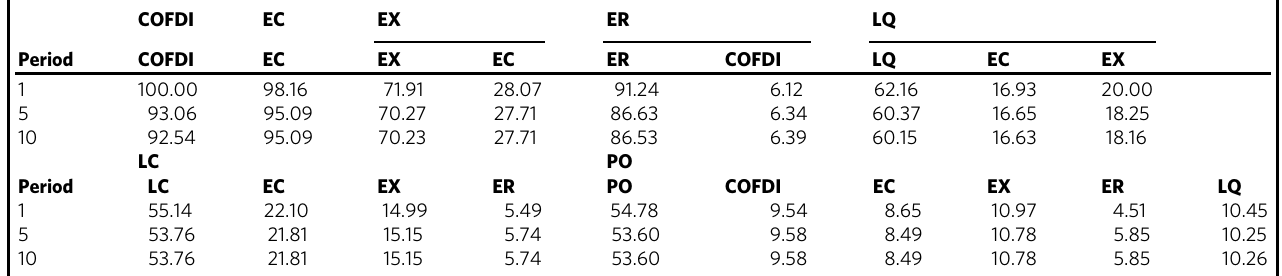
Table 11 Variance decomposition results